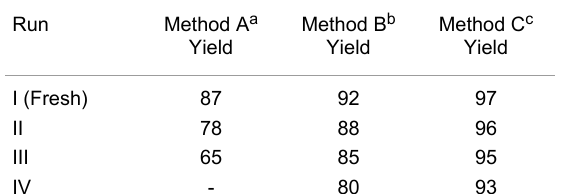
Table 3: Reusability of biocatalyst after I, II, III